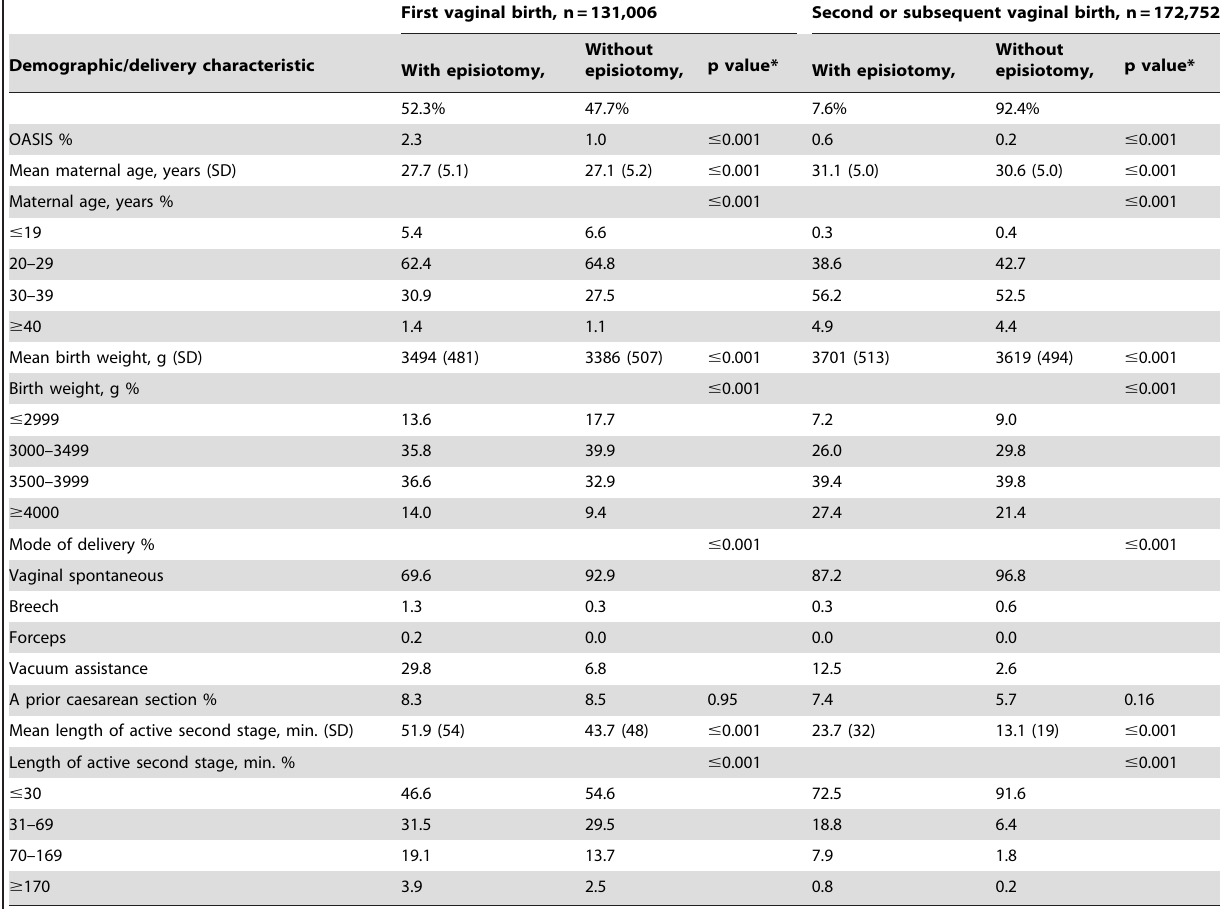
Table 2. Demographics and delivery characteristics among women with first vaginal singleton births including women with first vaginal births after a prior caesarean section and among women with second or subsequent vaginal births with and without episiotomy from 2004–2011 in